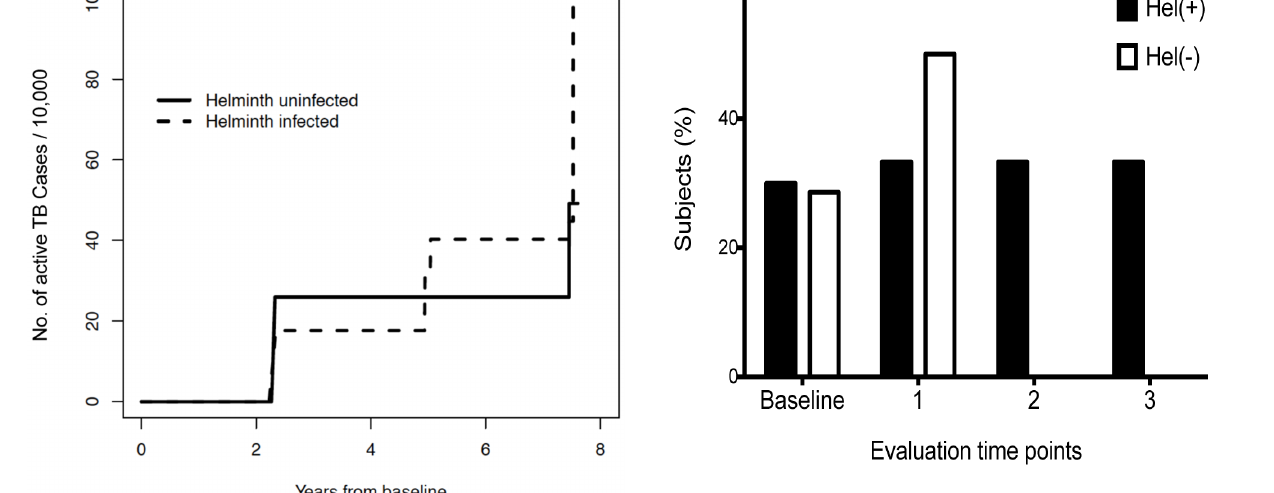
Figure 3. Severity of disease among subjects with active TB. Subjects in each group with bilateral lesions on chest radiographs (expressed as a percentage of all subjects with active TB who had complete chest X-ray data was available at the particular time point of evaluation) are shown for helminth-infected (dark bars) and helminth- uninfected (open bars) at each assessment time point. The percentage of subjects with evidence of severe disease in the hel + and hel– groups, respectively, were: 3/10 (30%) and 2/7 (29%) at baseline; 1/3 (33%) and 3/6 (50%) at 2.5-year follow-up; 1/3 (33%) and 0 at 5-year follow-up; and 1/3 (33%) and 0/1 at 7 ? 5-year follow-up with no significant differences seen between groups overall or at each time point of evaluation.